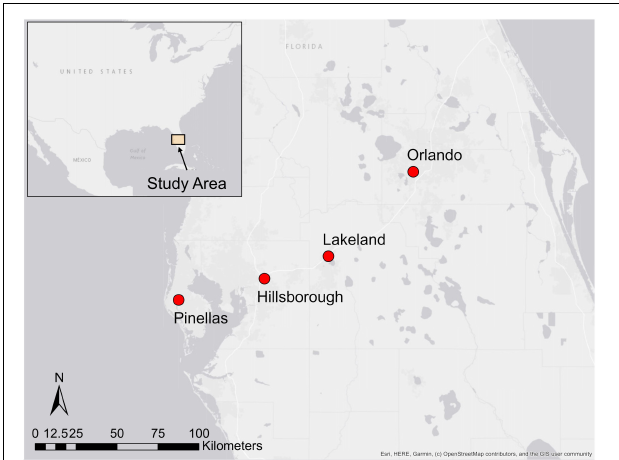
FIGURE 2 | Map of central Florida, US, showing partnering communities where trees were planted (red dots) for the establishment trial. Moving left to right, planting trial locations were Pinellas County, Hillsborough County, the City of Lakeland, and the City of Orlando. Representatives from each of these communities were members of the Central Florida Urban Forest Diversity Working Group that developed the planting